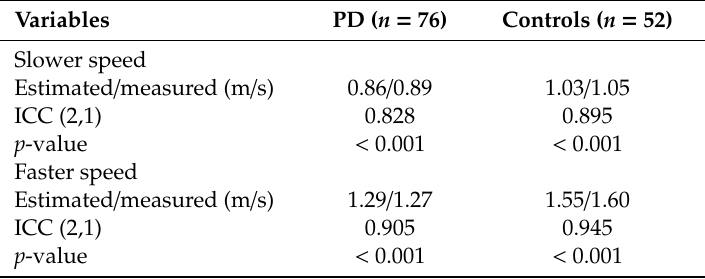
Table 2. Reliability of the results for slower and faster walking